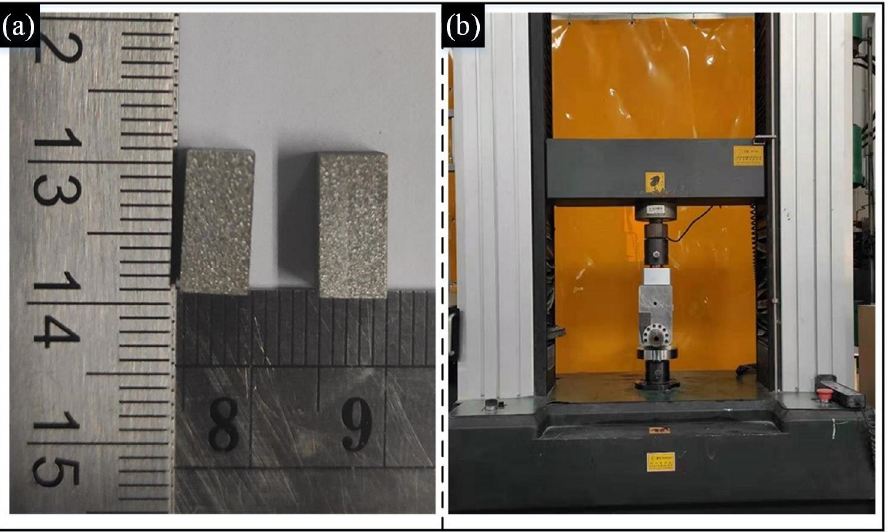
Figure 4. The compression test of cold-spray materials: ( a ) The specimens without shot peening; ( b ) the compression test.